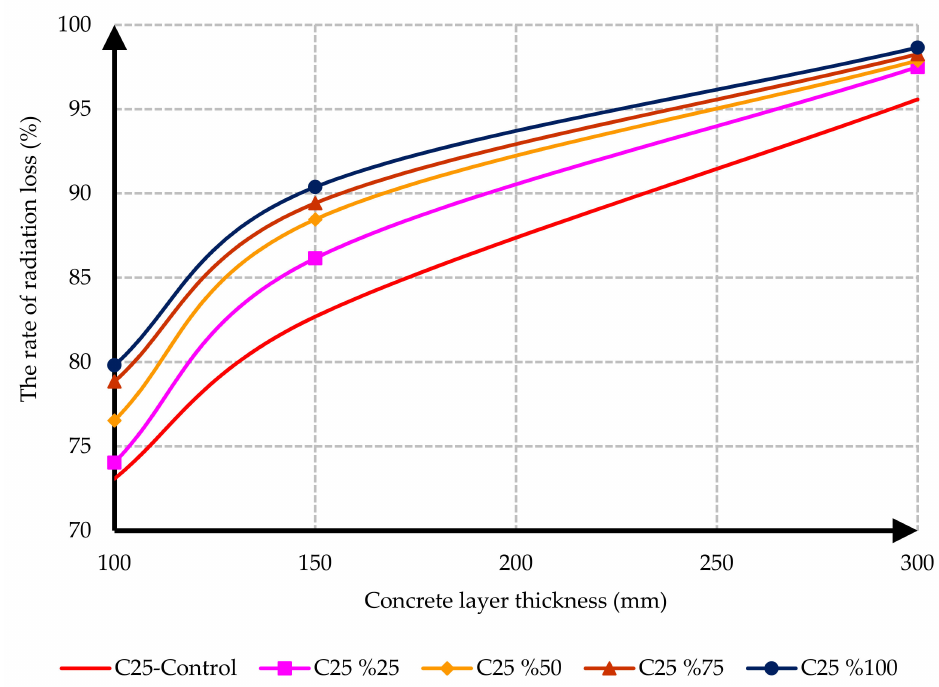
Figure 12. Effect of barite aggregates on the rate of radiation loss for C25 concrete mix designs.